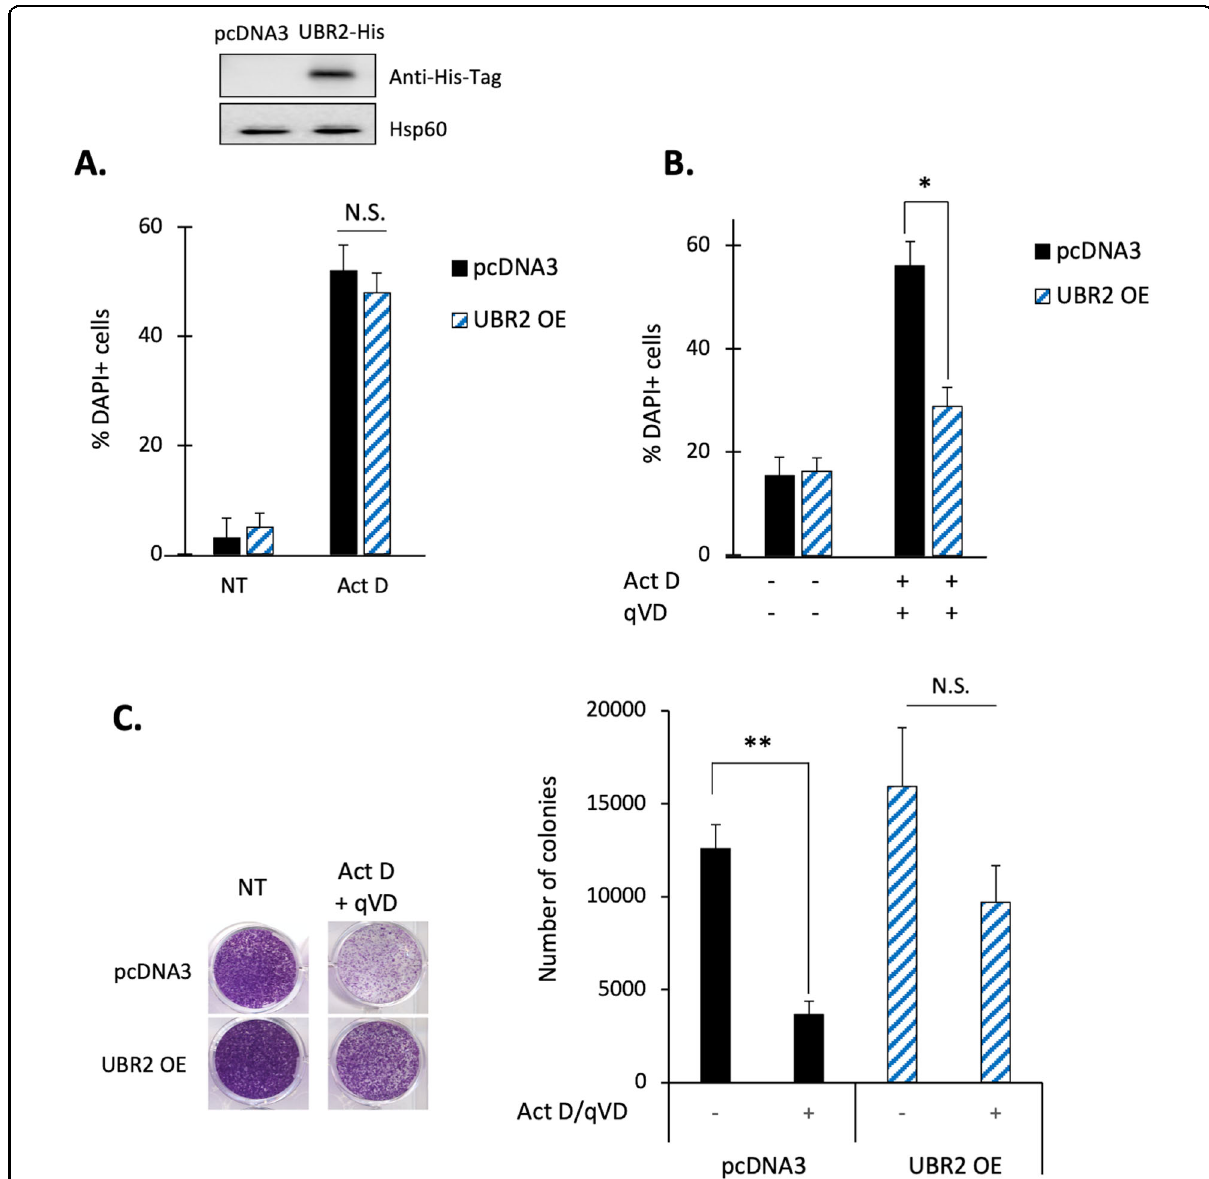
Fig. 4 UBR2 overexpression protects cells from CICD but not from apoptosis. A HeLa cells were transfected to transiently overexpress (OE) the control vector